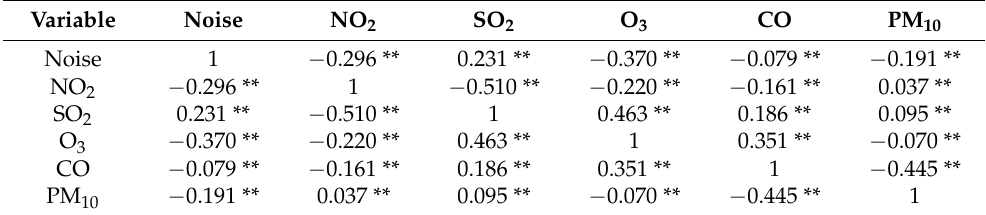
Table 3. Assessment of correlation between night-time noise estimates and air